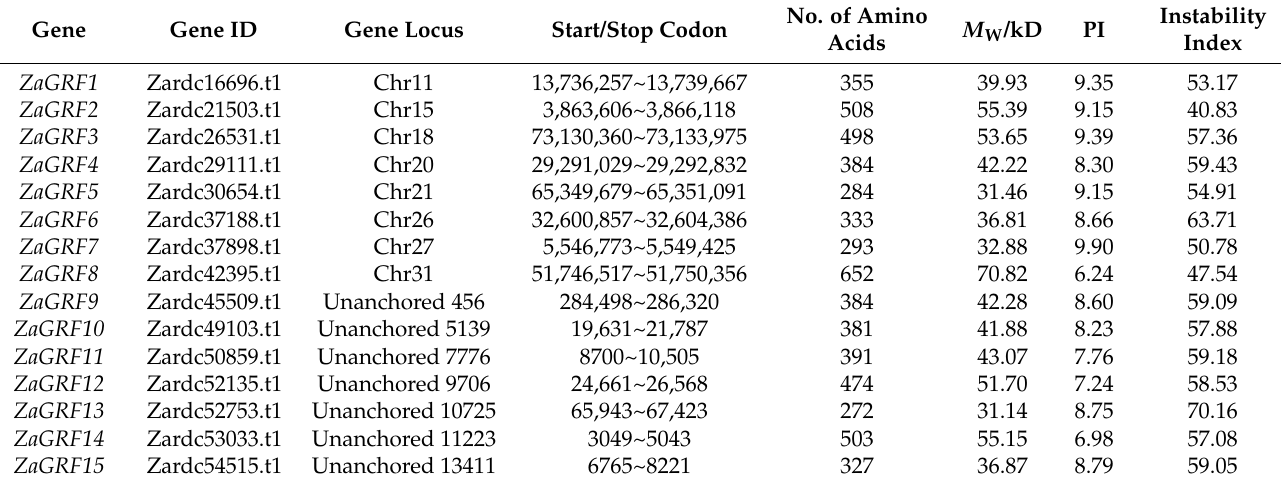
Table 1. Protein features of GRFs of Z. armatum .